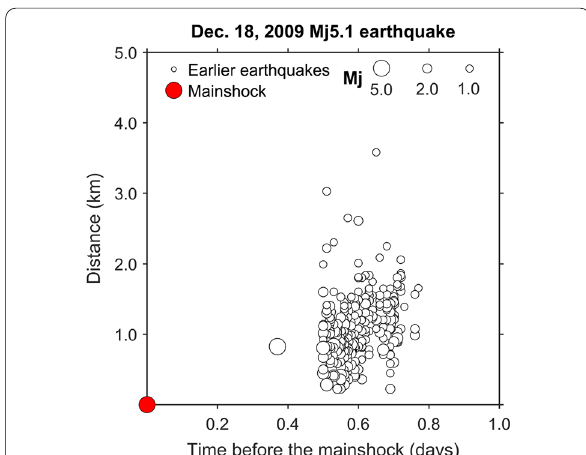
Fig. 3 An example of earthquake swarm on December 18, 2009. The red circle is the mainshock, white circles are earlier earthquakes within 30 days and 30 km (most of them are within 1 day and 5 km), magnitudes are shown by the size of circles. This sequence includes 277 earlier earthquakes, which is an order of magnitude more than the typical foreshock occurrence levels which are usually 1 to 15